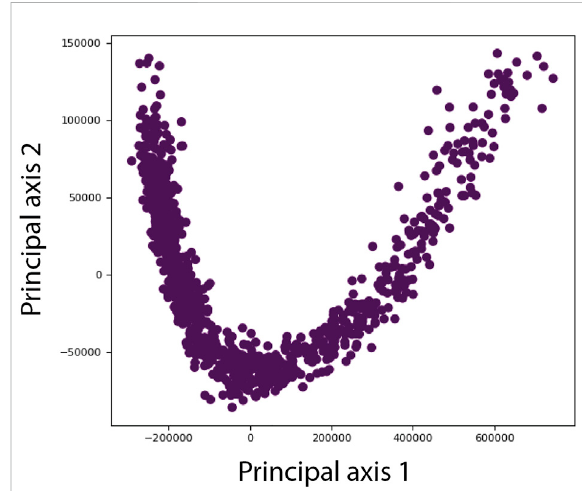
FIGURE 4 Illustration of a lower-dimensional (here, 2D) conformational space obtained by principal component analysis of the conformational parameters (normal-mode amplitudes) estimated by HEMNMA or predicted by the neural network of DeepHEMNMA. Different points represent different particle images.Eachpointcorrespondstotheconformationalparameters (normal-mode amplitudes) of the molecular complex in the correspondingsigle-particleimage.Foreachpoint,theorientation and position of the molecular complex are also available (estimated by HEMNMA or predicted by the neural network) and can be used to calculate 3D reconstructions from interactivelly selected groups of images with similar conformations in the densest regions of this space (not shown in this illustration but in the experiments